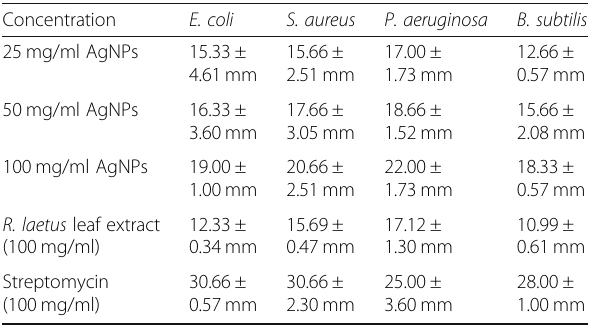
Table 2 Antibacterial activity of R. laetus -mediated AgNPs and leaf extract Concentration